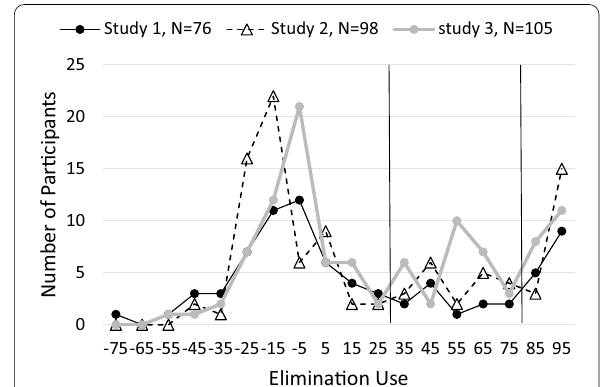
Fig. 3 Histograms of elimination use for studies 1, 2, and 3. Vertical lines are used to define consistent use of backtracking (either form) and elimination (see